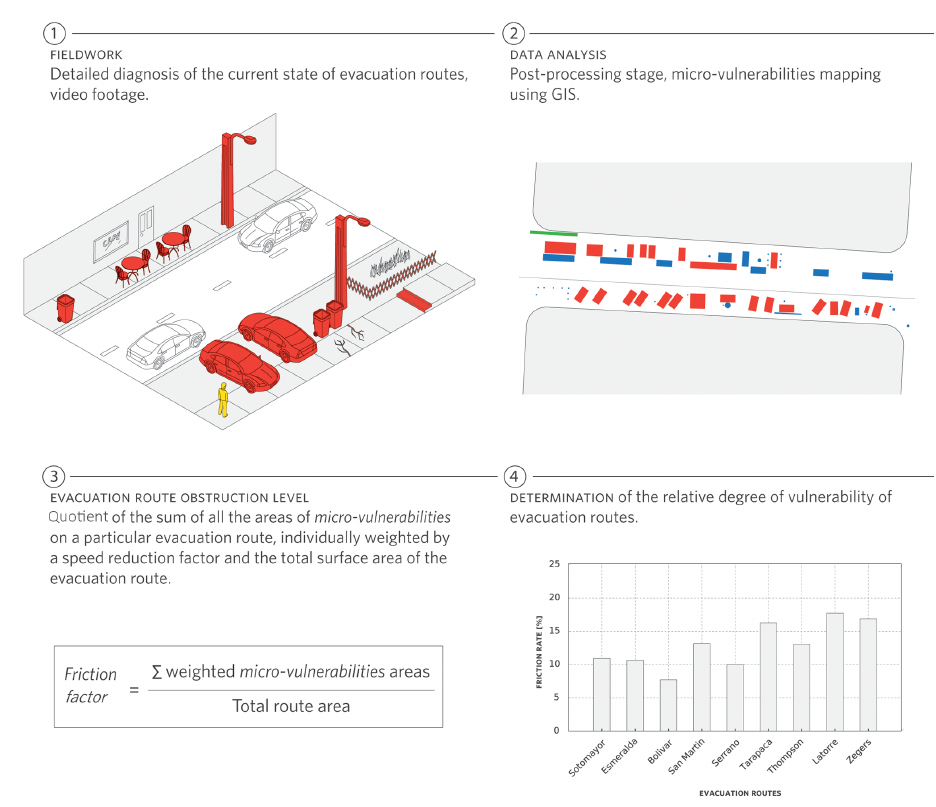
Figure 2. Summary of the proposed methodology to identify and classify urban micro-vulnerabilities.